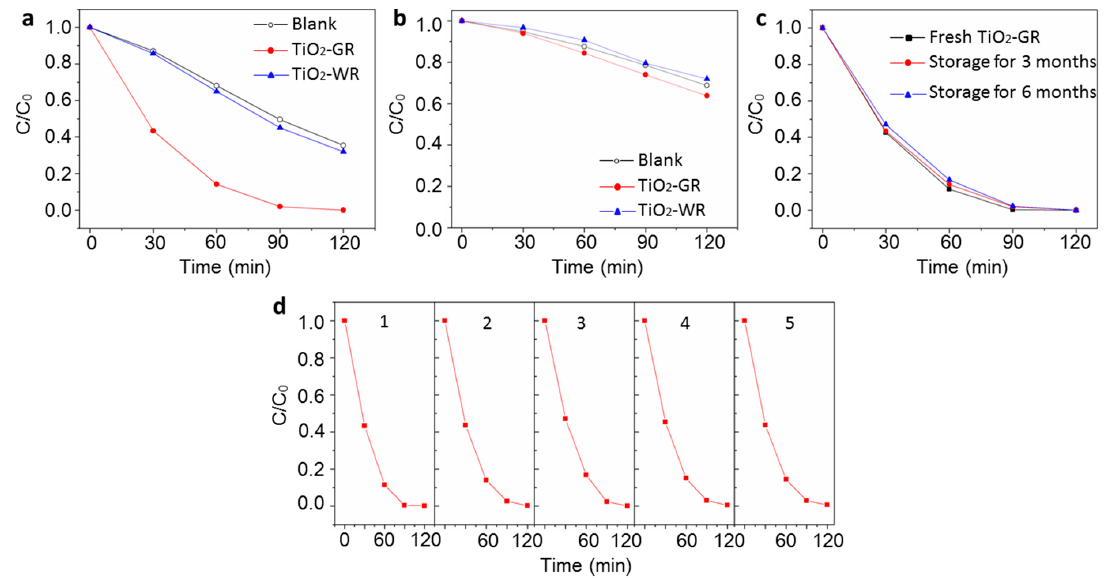
Figure 5. ( a ) Methylene blue (MB) dye photocatalytic discoloration plots of TiO 2 -GR and TiO 2 -WR samples under full-spectrum light irradiation; ( b ) MB dye photocatalytic discoloration plots of TiO 2 -GR and TiO 2 -WR samples under visible light irradiation; ( c ) photocatalytic activity tests of TiO 2 -GR samples stored for different times via the photocatalytic discoloration of MB dyes under full-spectrum light irradiation; ( d ) photocatalytic activity cycle tests of TiO 2 -GR samples under full-spectrum light irradiation. The aqueous solution of the MB dyes (10.0 mg / L, 30.0 mL) without photocatalysts was used as the control sample marked as a blank in Figure 5a,b. C / C 0 is the ratio of the real-time concentration to the initial concentration of MB dyes.